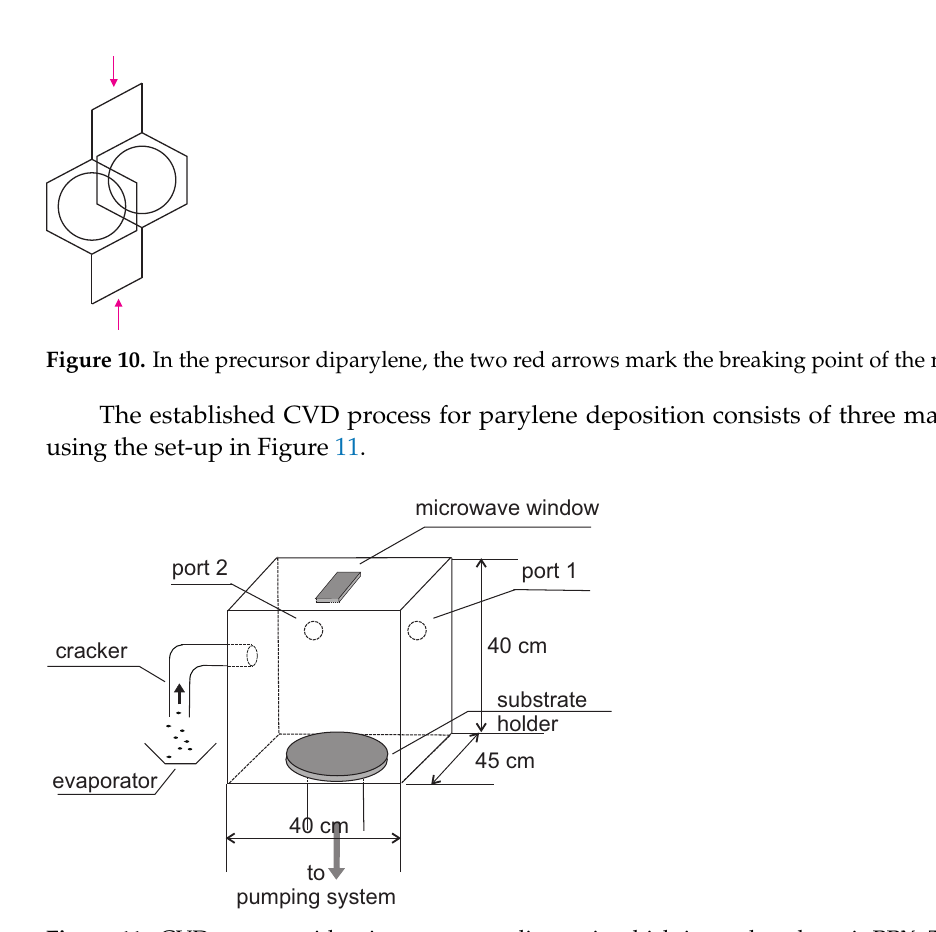
Figure 11. CVD reactor with microwave coupling unit which is used to deposit PPX. The film- building monomers enter the reactor on the LHS and will be pumped out through the annular gap below the circular substrate holder at the bottom [56]. The pump is protected against organic vapor by a cold trap ( − 90 ◦